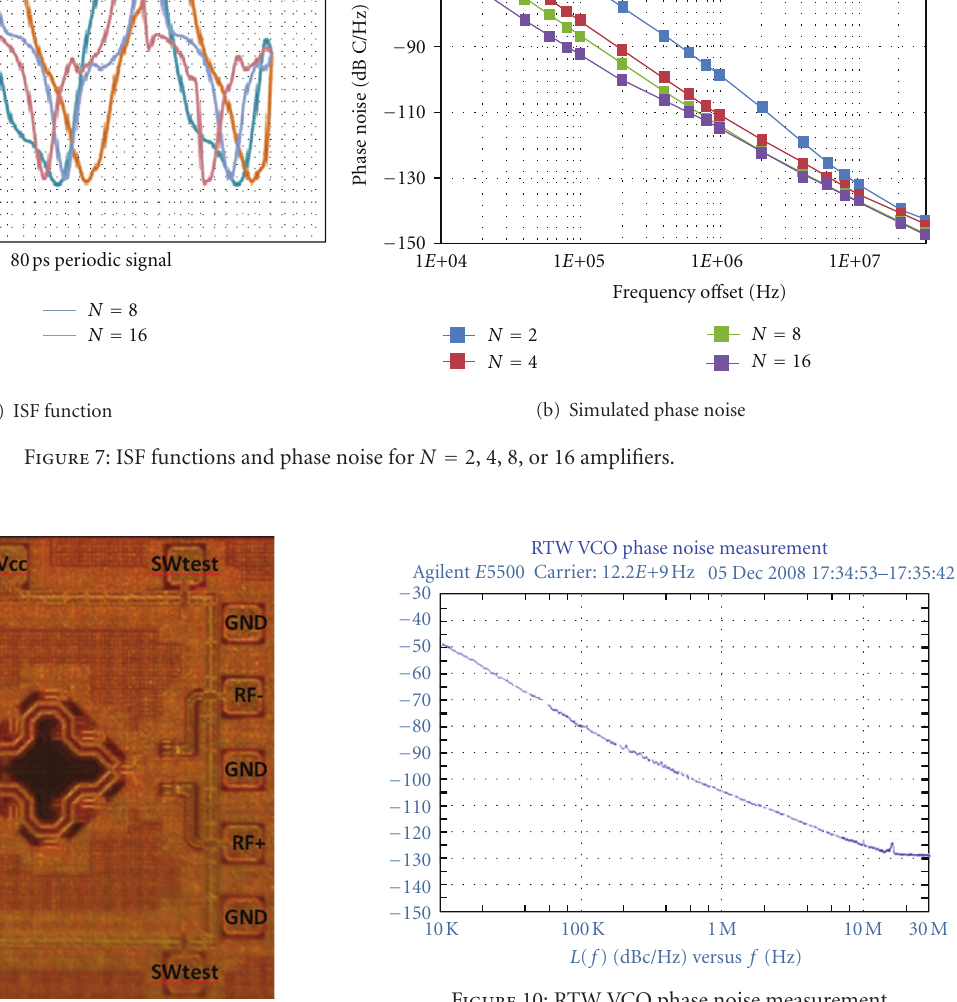
Figure 8: RTW VCO microphotography.